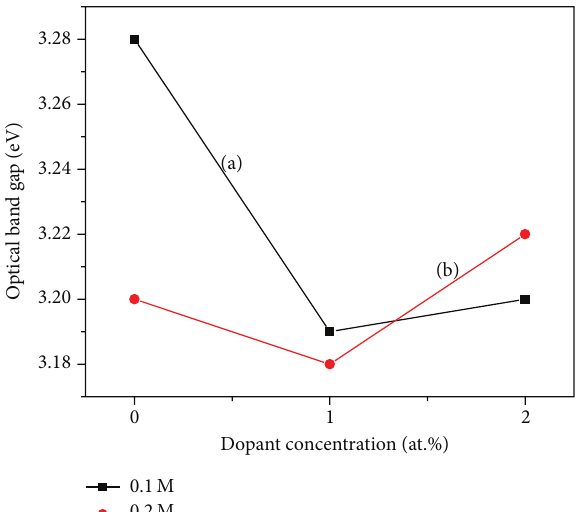
Figure 5: The variation in band gap (a) and (b) corresponds to the sample prepared using precursor solution of molarity of 0.1 and 0.15M, respectively.